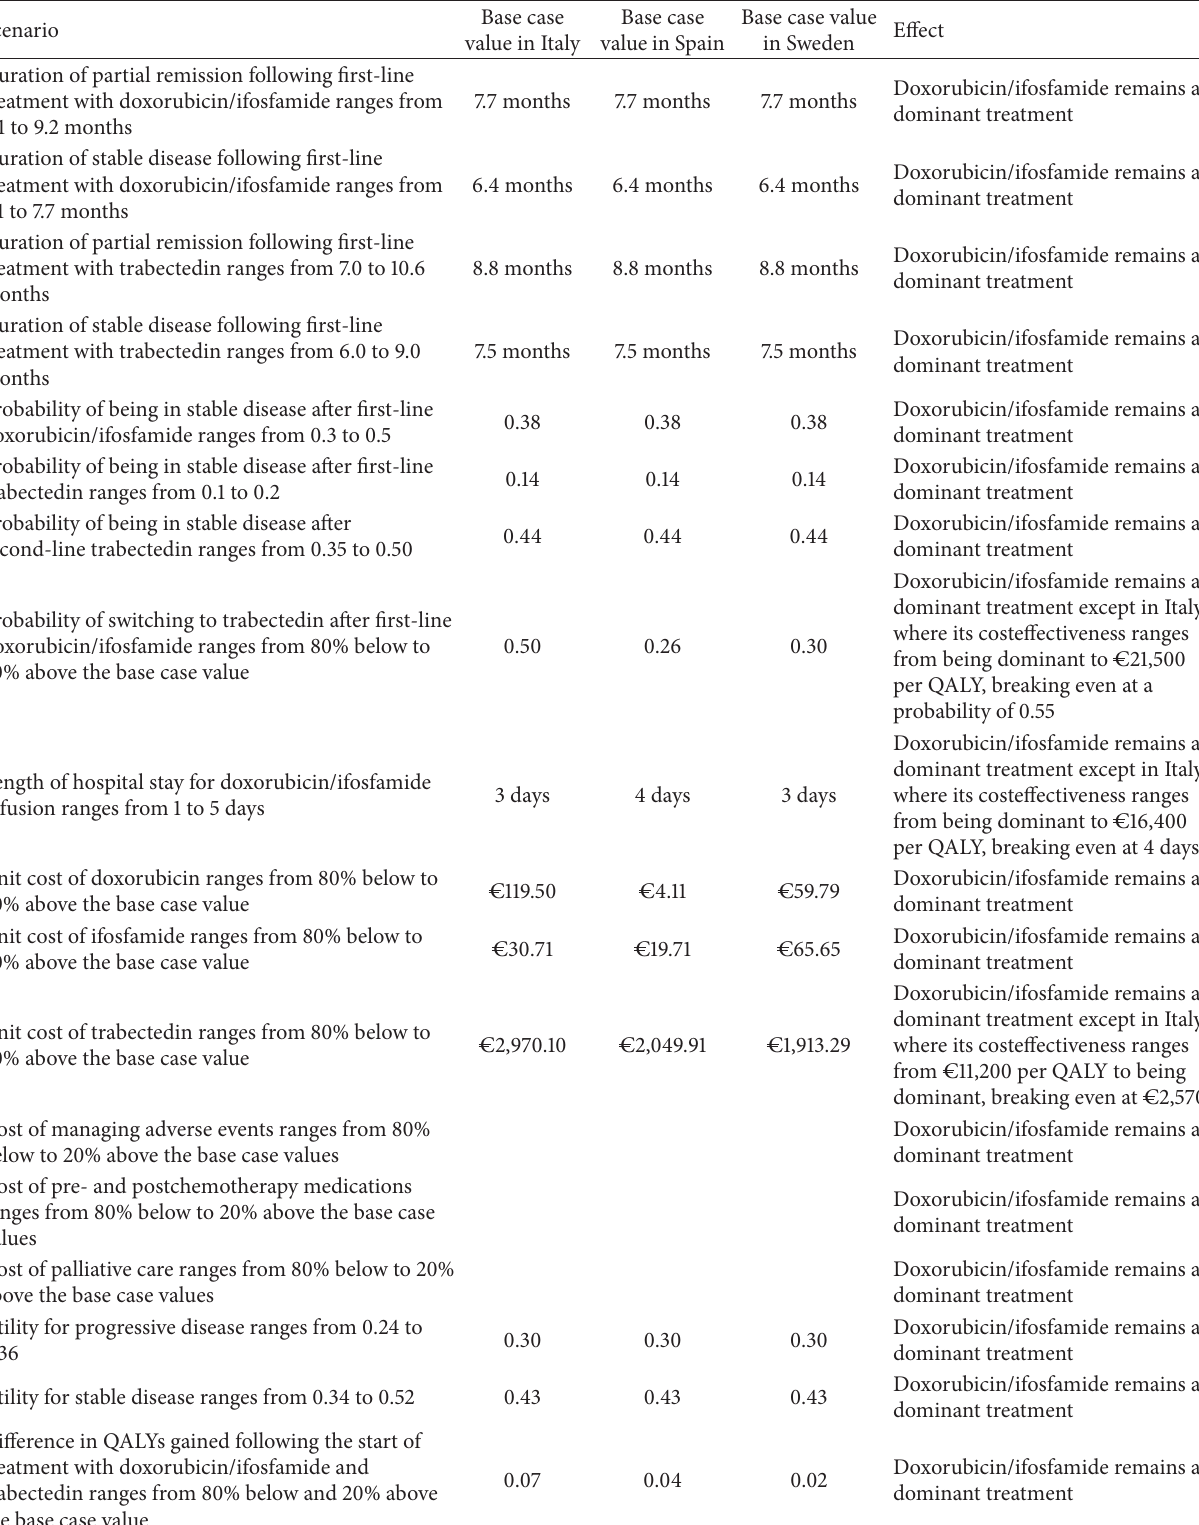
Table 8: Sensitivity